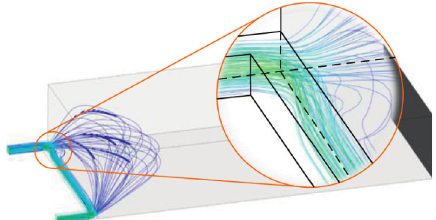
Figure 14: Airflow in gob